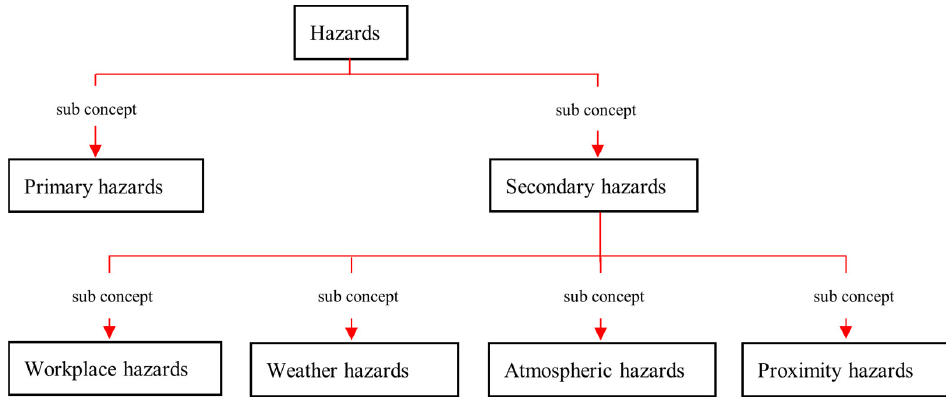
Figure 6. The sub-concepts of hazards.